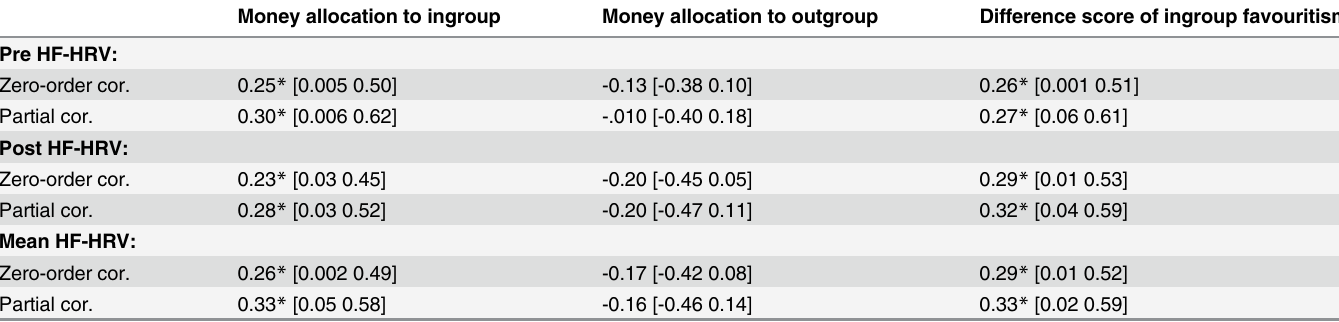
Table 1. The BCa bootstrapped estimates and 95% confidence intervals of zero-order and partial correlations of Tajfel matrices variables with HRV